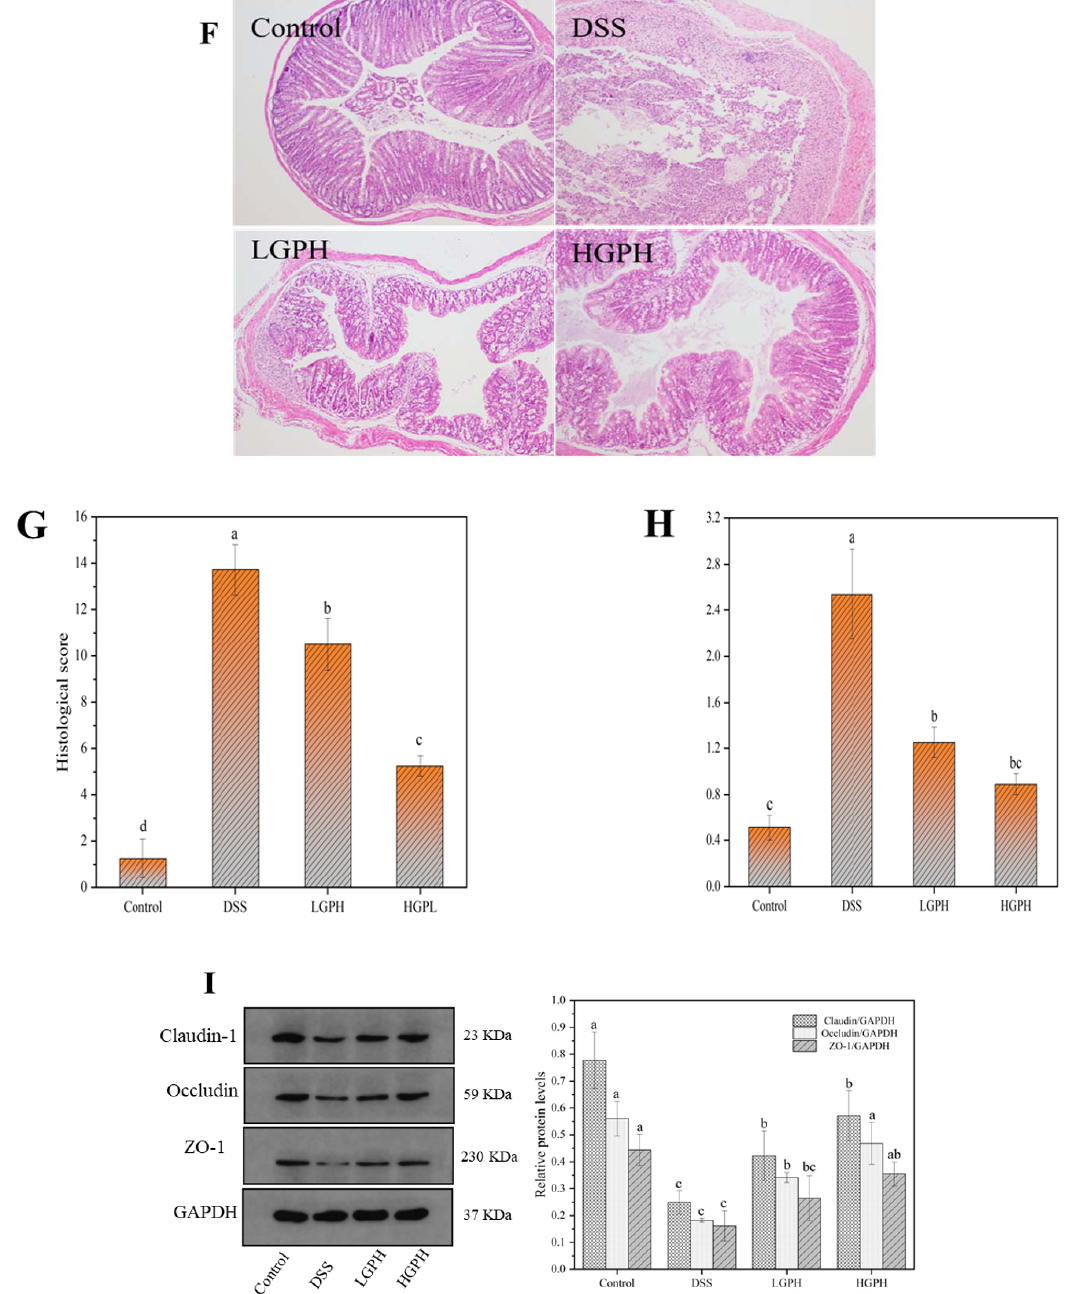
Figure 2. GPH extracts mitigated the symptoms and relieved the colonic injury and inflammatory infiltration of DSS-induced UC mice. ( A ) Schematic diagram of the experiment; ( B ) body weight; ( C ) DAI score; ( D ) representative photographs of colon length; ( E ) quantitative results of colon length; ( F ) representative photographs of H&E staining of colonic tissues (magnification ×100); ( G ) histopathological score of colonic tissues; ( H ) MPO activity of colonic tissues; ( I ) expression of tight junction proteins in colonic tissues. Values not sharing a common superscript letter denote significant difference ( p < 0.05).